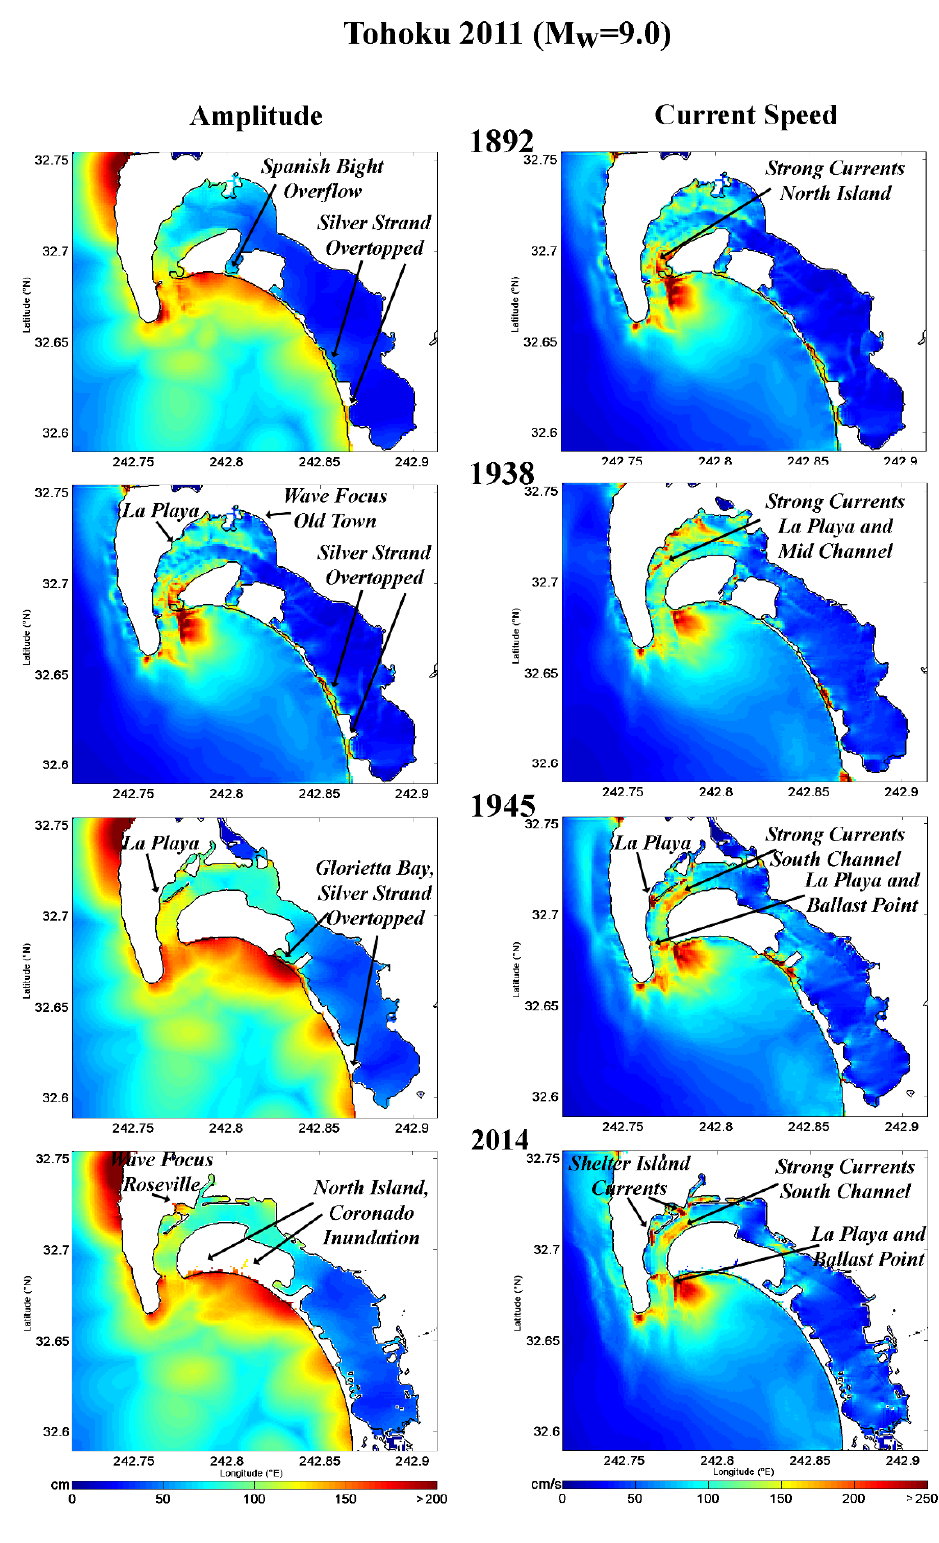
Figure 8. Maximum wave amplitude and maximum current distribution in San Diego harbor for four different configurations (1892, 1938, 1945, and 2014). A tsunami scenario resembling the 11 March 2011 Tohoku tsunami was used to investigate changes in wave dynamics as a result of anthropogenic changes. Years indicate time tagging of large changes in the harbor. Left column shows wave heights in cm; right column tsunami currents in